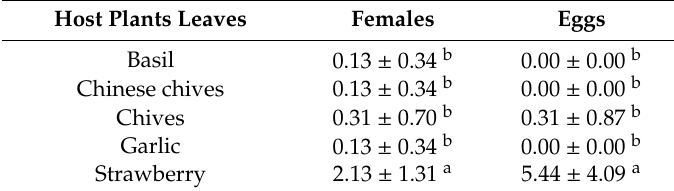
Table 1. Mean number ( ± Standard deviation) of adult females and number of eggs laid by Tetranychus urticae on strawberry or aromatic plant leaves during the multiple-choice test, after 24 h. Host Plants Leaves Females Eggs Basil 0.13 ± 0.34 b Chinese chives Garlic Strawberry 5.44 ± 4.09 a Means ± Standard deviation followed by the same letter are not significantly different for Kruskal – Wallis and SNK test ( p > 0.01).